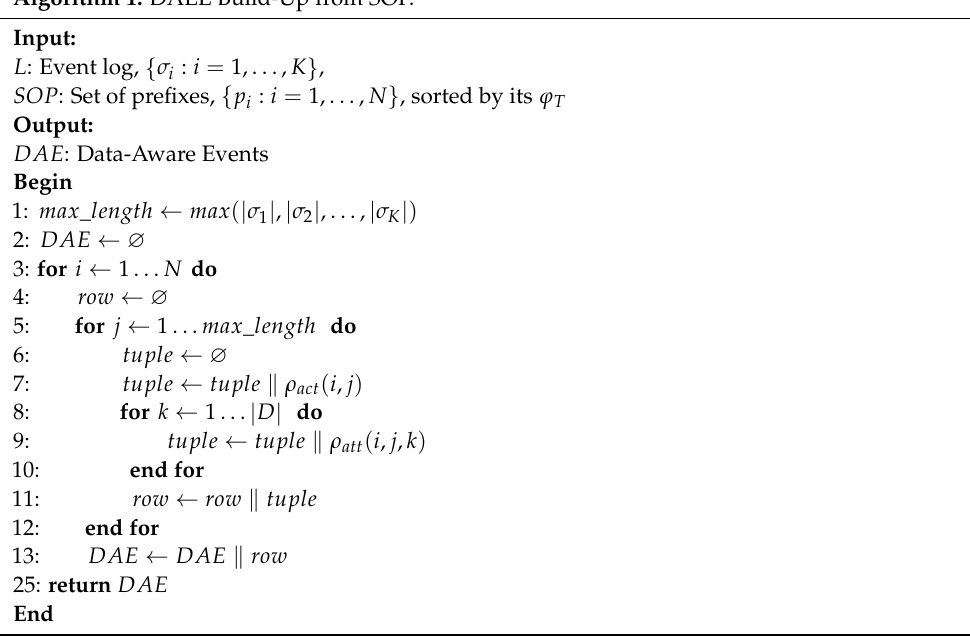
Algorithm 1. DAEE Build-Up from